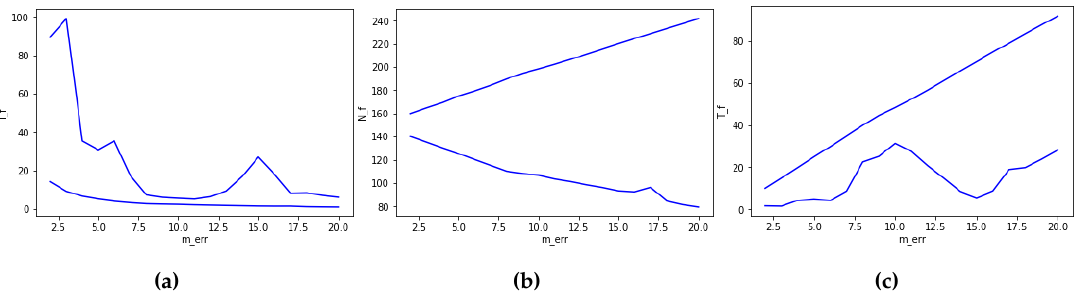
Figure 11. The three plots show the values assumed by the extreme values (15) as a function of m err